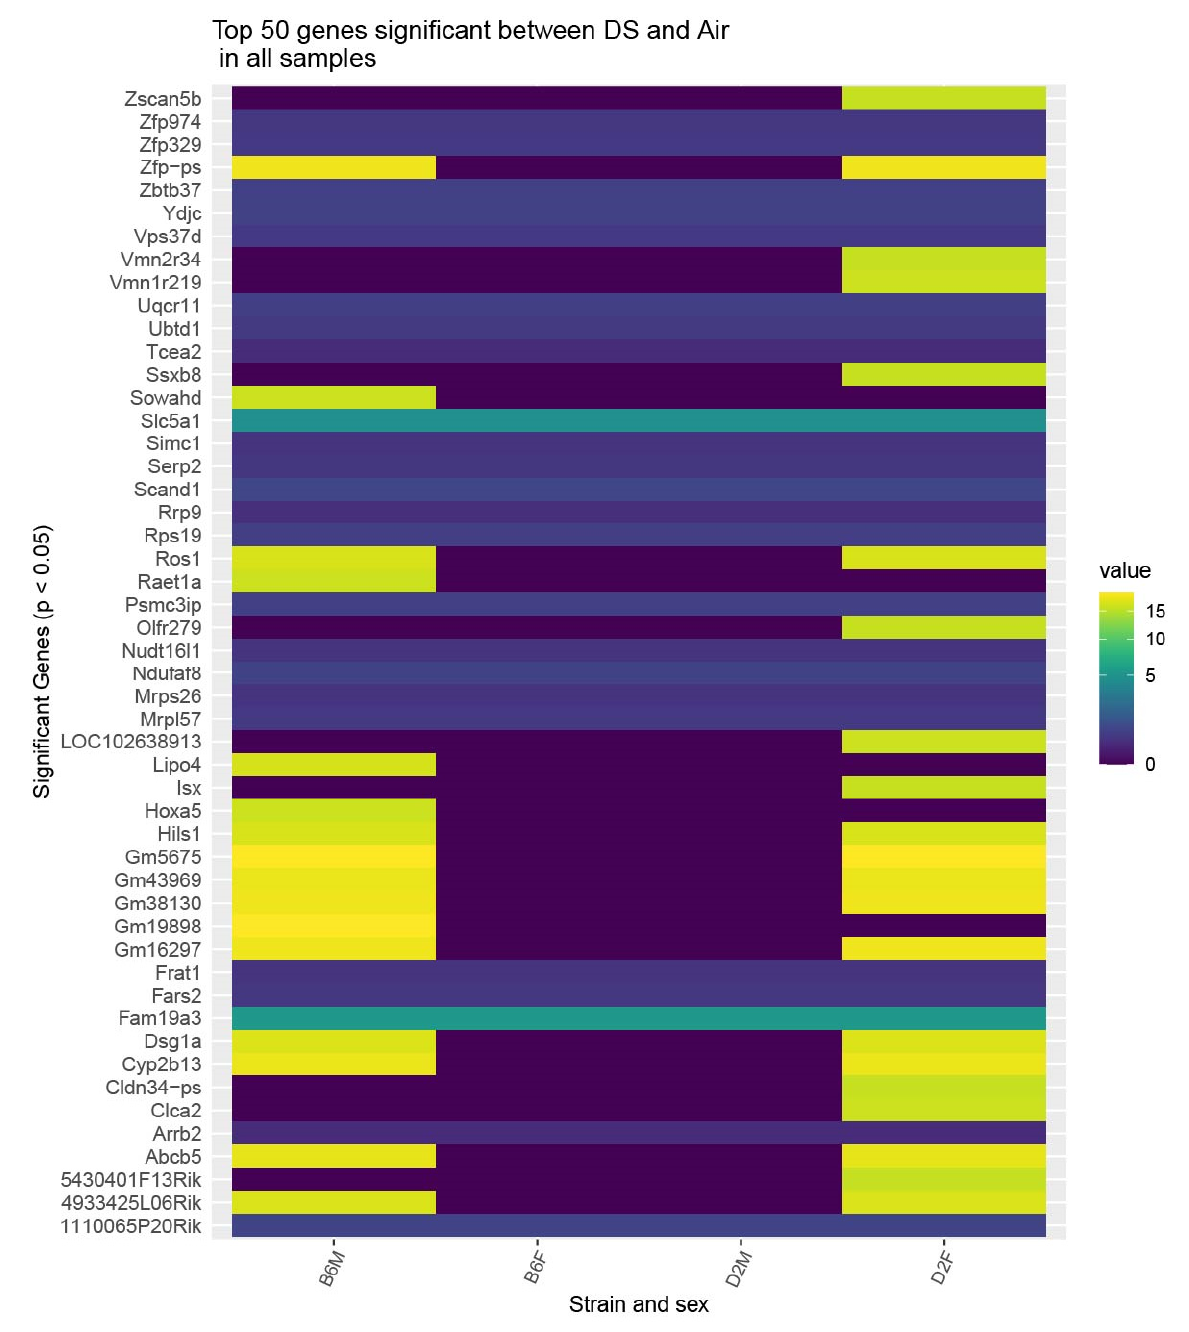
Figure 5. Heatmap of the top 50 genes differentially expressed between all diesel exposed (n = 7) and control (air n = 8) animals, split by strain (C57BL/6J = B6, DBA/2J = D2) and sex (male = M, female = F). Some genes, such as Slc5a1 and Fam19a3 , evinced a consistent fold change in all subsets, whereas others are driven by only a subset, often B6M or D2F. Data are absolute values of differential expression, diesel exposure vs. control. All differential expressions were significant at p < 0.05 or less.